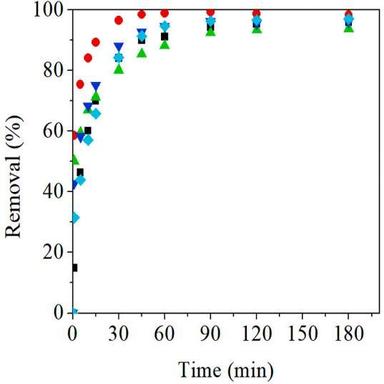
Results of the experiments studying the UV-light effect on the removal of DR80 from solution. pH0 = ■ 2.5; 4; 5.5; 7; 8.5. Other reaction conditions: doseH2O2 = 1.5 mmol L− 1 and doseFe = 2 mg L− 1 .